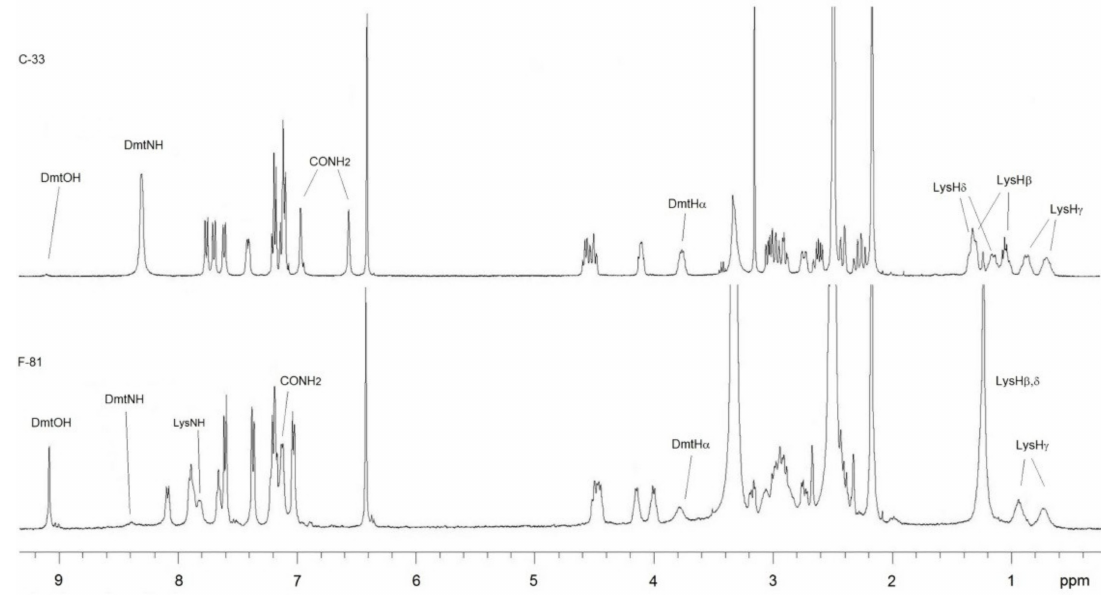
Figure 4. 1 H-NMR spectra at 400 MHz in 8:2 DMSO- d 6 /H 2 O of C-33 and F-81; peaks flattened by water pre-saturation are also